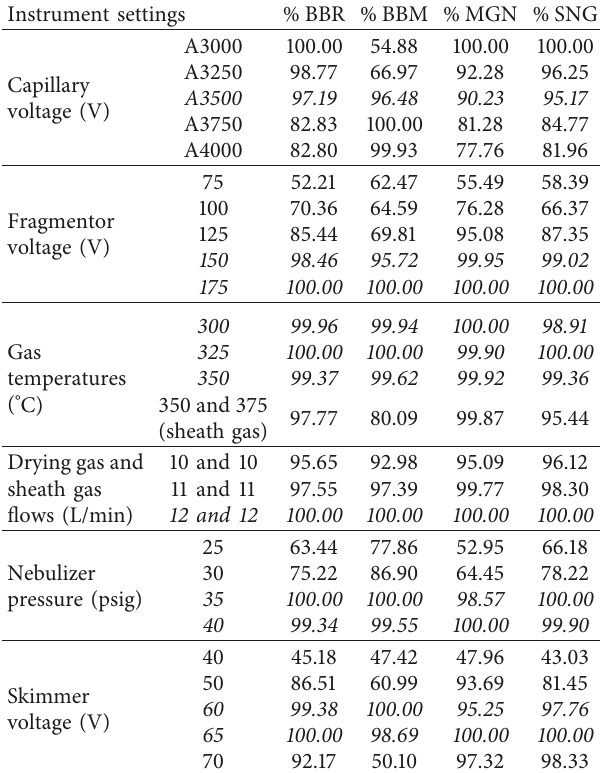
Table 2: The influence of spectrometric parameters on the de- termination of the studied four representatives of isoquinoline alkaloids, expressed in the peak area of the compounds in relation to the highest one in each group (in percent). The most optimum settings for all groups of alkaloids are in italics. Instrument